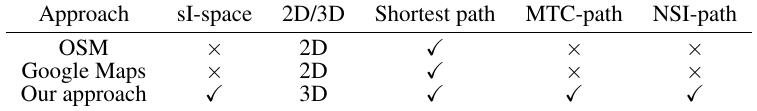
Figure 12. Navigation paths of C (cid:32) D. The part marked by black ellipse shows where the sI-spaces are involved in MTC-path. Table 4. Comparisons of three navigation systems. × means no while (cid:88) means